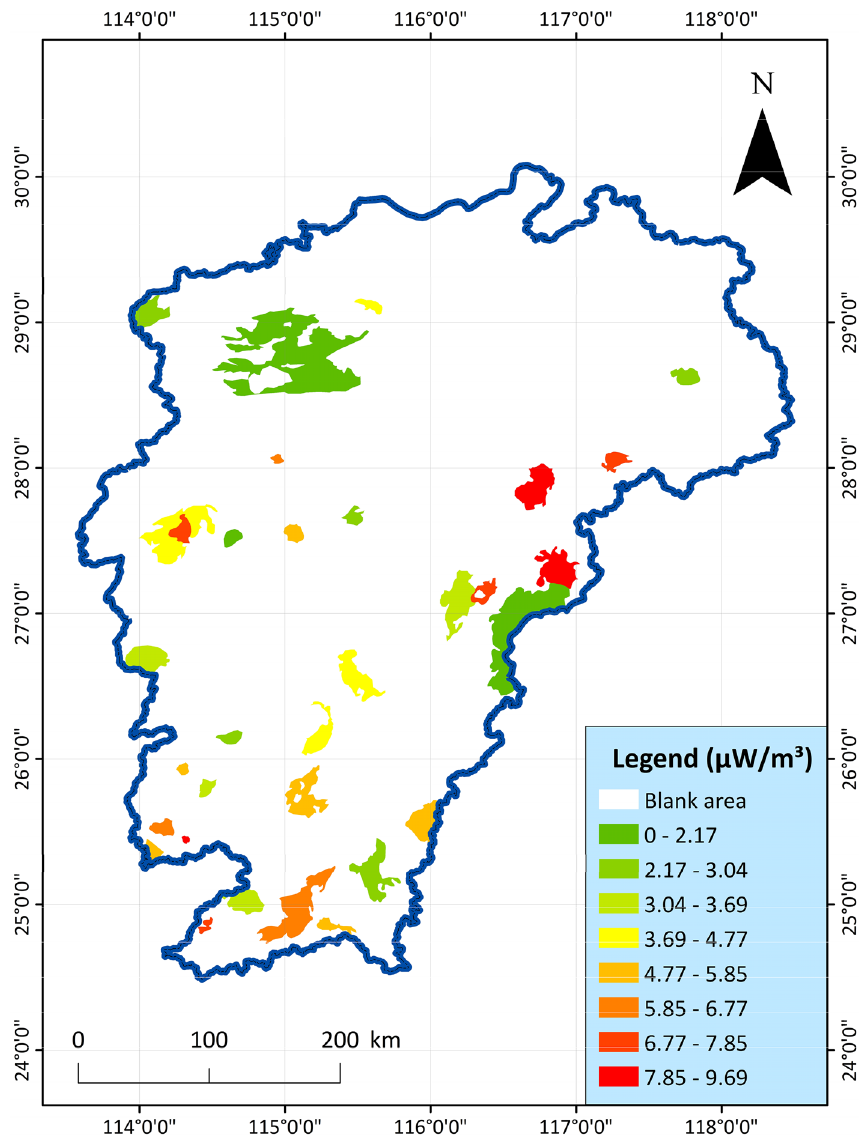
Figure 11. Distribution map of radioactive heat generation rate of acid magmatic rocks in Jiangxi Province 28